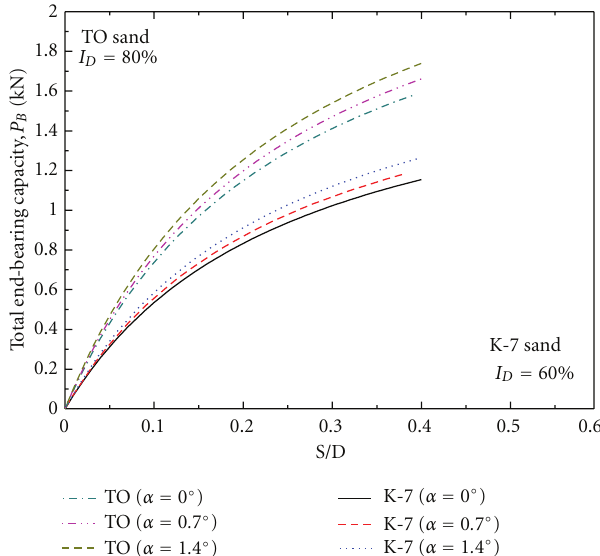
Figure 5: Total end-bearing capacity of TO and K-7 sands of diffe- rent piles at normalized settlement ratio.